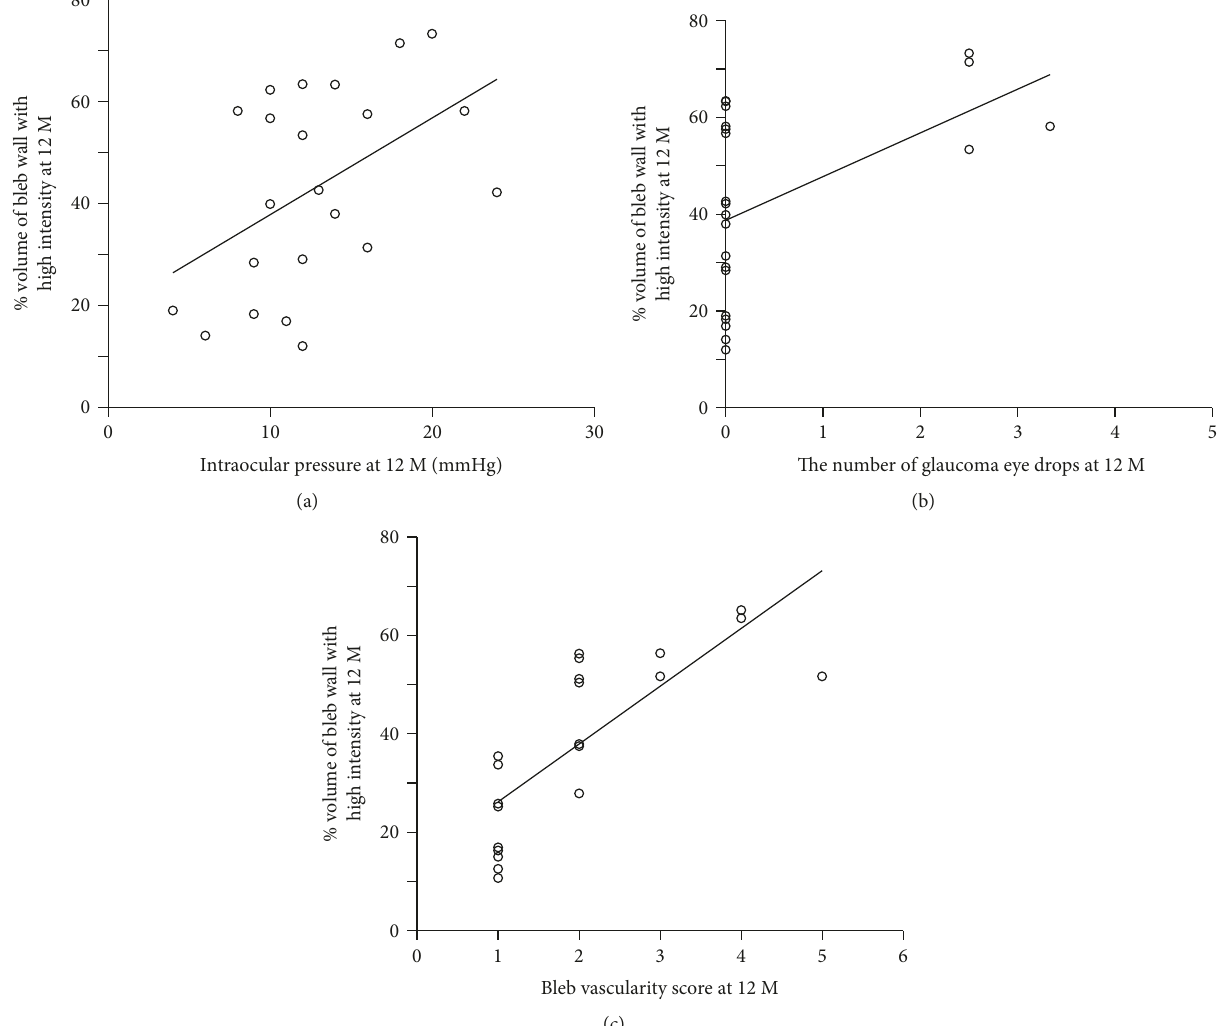
Figure 4: Scatter plots of the 12-month high-intensity volume ratios of bleb walls with 12-month intraocular pressures (IOPs) (a), 12-month requirements for antiglaucoma eye drops (b), and 12-month bleb vascularity scores (c) after trabeculectomy. The lines are linear